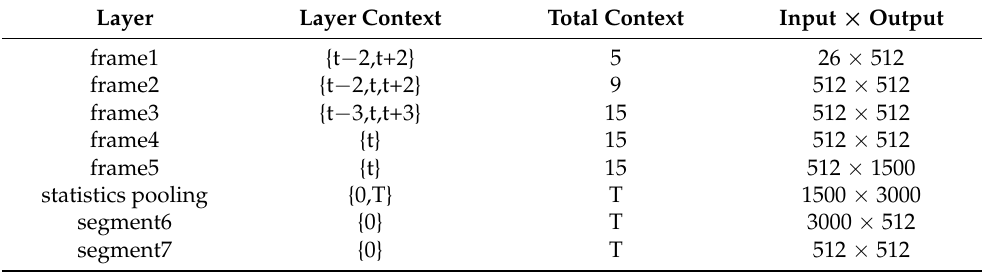
Table 1. The embedding TDNN architecture. x-vectors are extracted at layer